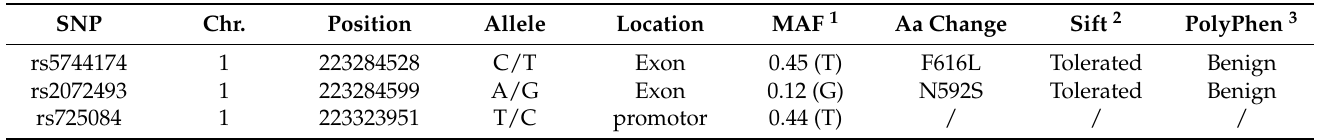
Table 3. List of the single nucleotide polymorphisms (SNPs) analyzed in the study, minor allele frequency and functional consequence according to SIFT and PolyPhen,